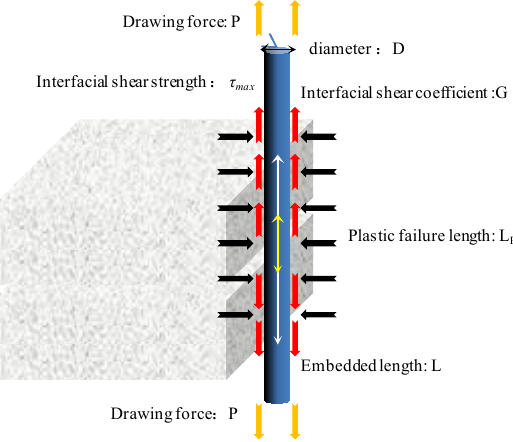
Figure 6. Stress analysis of optical fiber in rock mass.